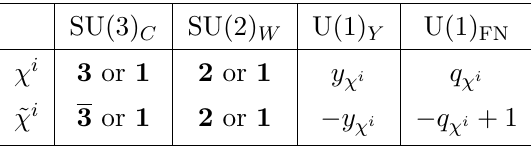
Table 5 . Gauge charges of the spectator (cid:12)elds.